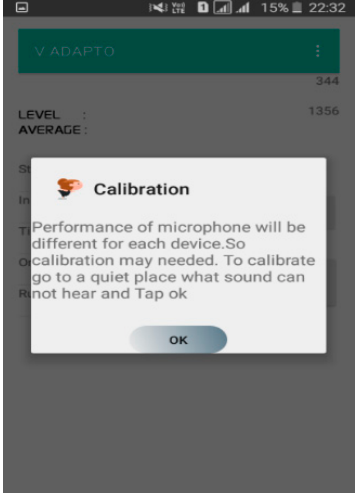
Figure 3. Calibration dialog window. Sensors 2020 , 20 , x FOR PEER REVIEW